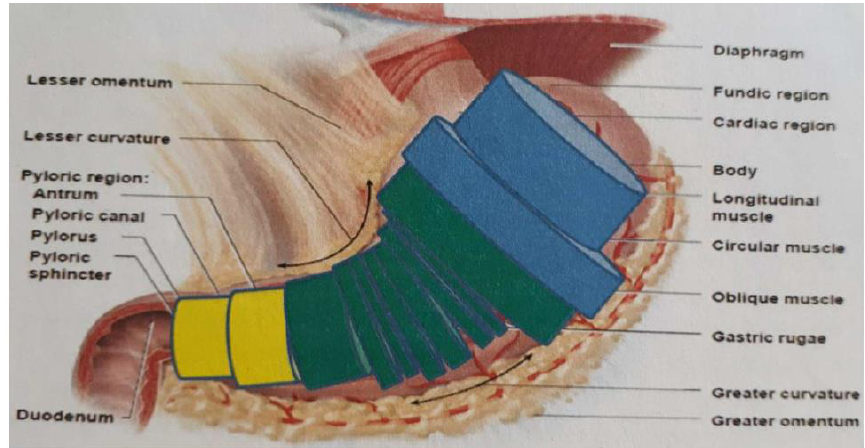
Figure 5. Approximation of the extended stomach with cylinders.